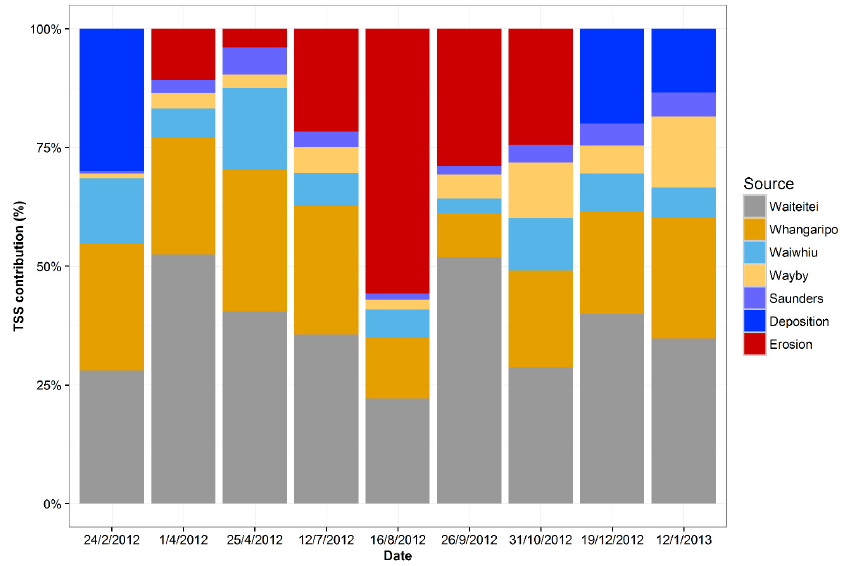
Figure 8. Sub-catchment suspended sediment budgets for the 2012–2013 period. Total suspended solids (TSS) contributions were calculated in t/day and are expressed as percentage of total exiting the Hoteo catchment. Net storage (deposition) occurred when the sum of TSS of all sub-catchments exceeded TSS exiting the catchment outlet, while net loss (erosion) occurred when more TSS exited the catchment outlet than was delivered by the sub-catchments.